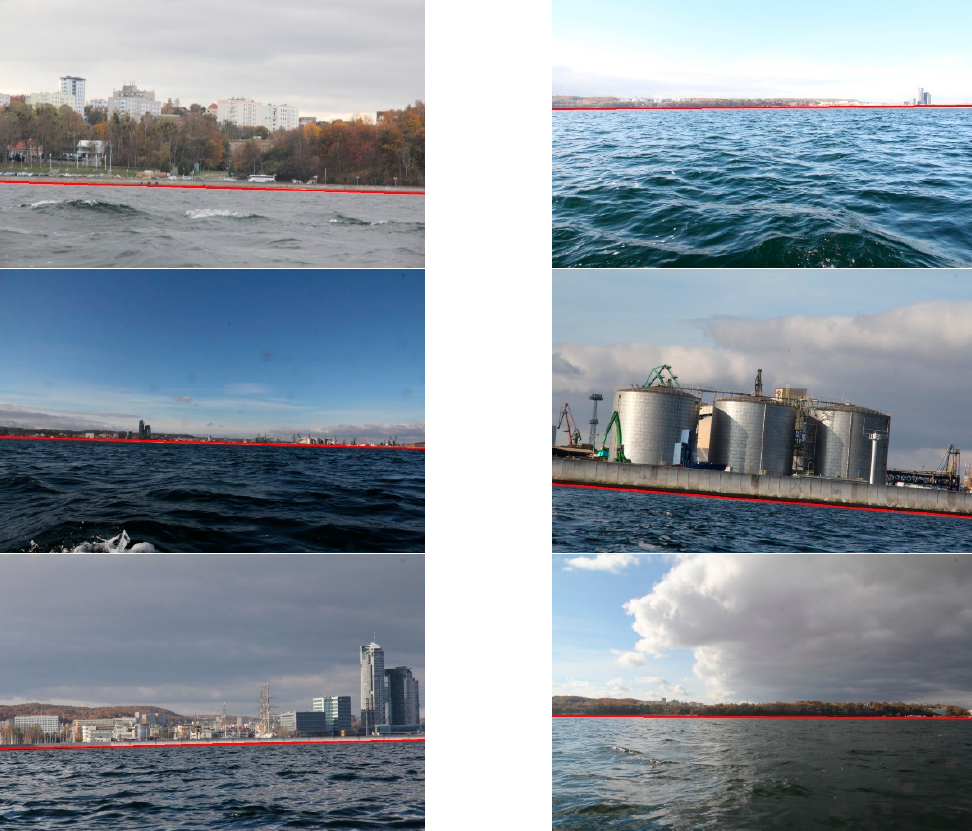
Figure 11. Results of shoreline detection.